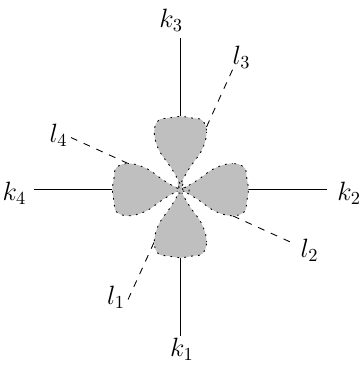
Figure 2 . The vertex given by eq. (3.18)–(3.19) depicted for N = 4 . The shaded blobs represent the opaque